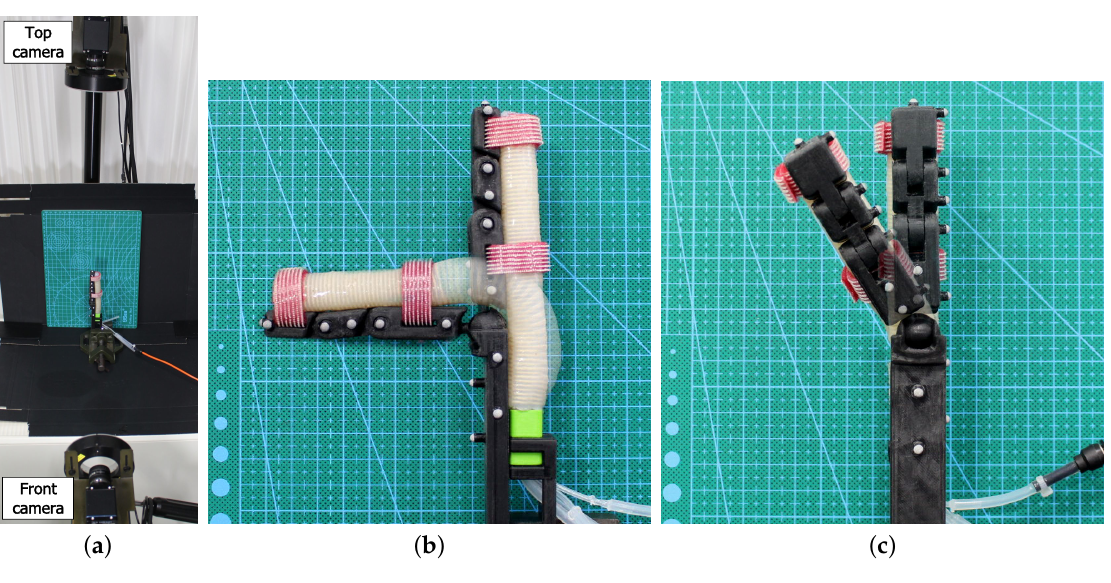
Figure 5. Motion capture measurement setup, showing the prototype with the combined